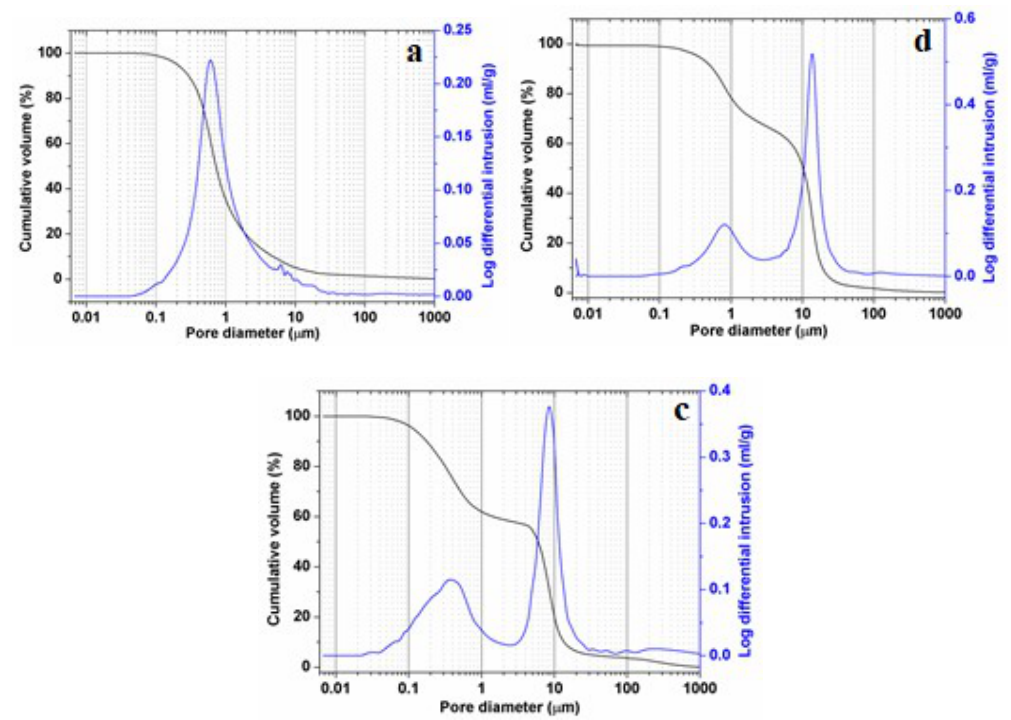
Figure 10. Pore-size distribution from mercury porosimetry of SA-SC blends ( a ), PS-SC blends ( b ) and ternary mixture (SA-PS-SC) ( c ) heated at 900 °C.